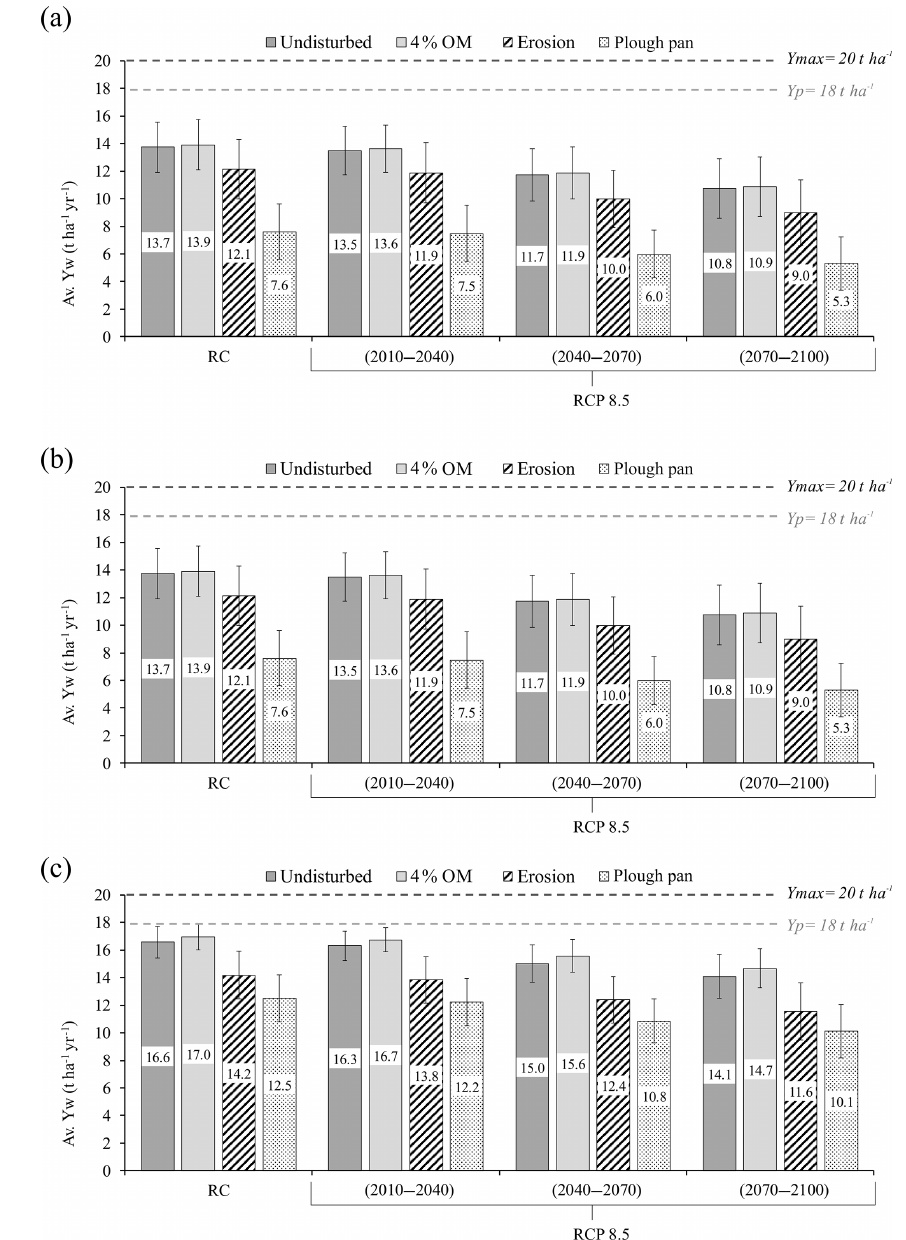
Figure 1. The average Yw of four soil phenoforms for three soils, (a) P4, (b) P5 and (c) P6, under reference (RC) and future climate scenarios (RCP 8.5). Yp is the local current potential production, and Ymax is the maximum potential production under unstressed field conditions (i.e. water, nutrients and pests or